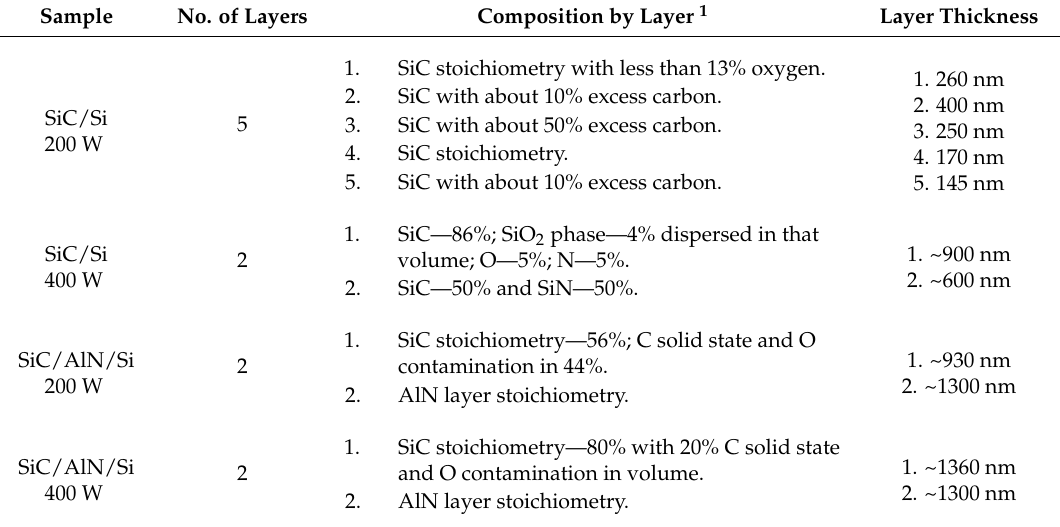
Table 1. Results of the RBS